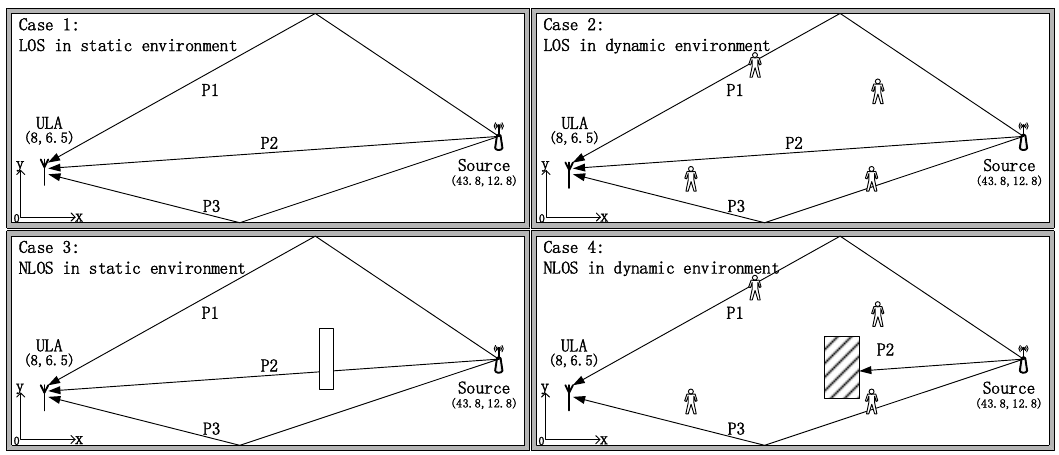
Figure 3. Diagram of different indoor environments.